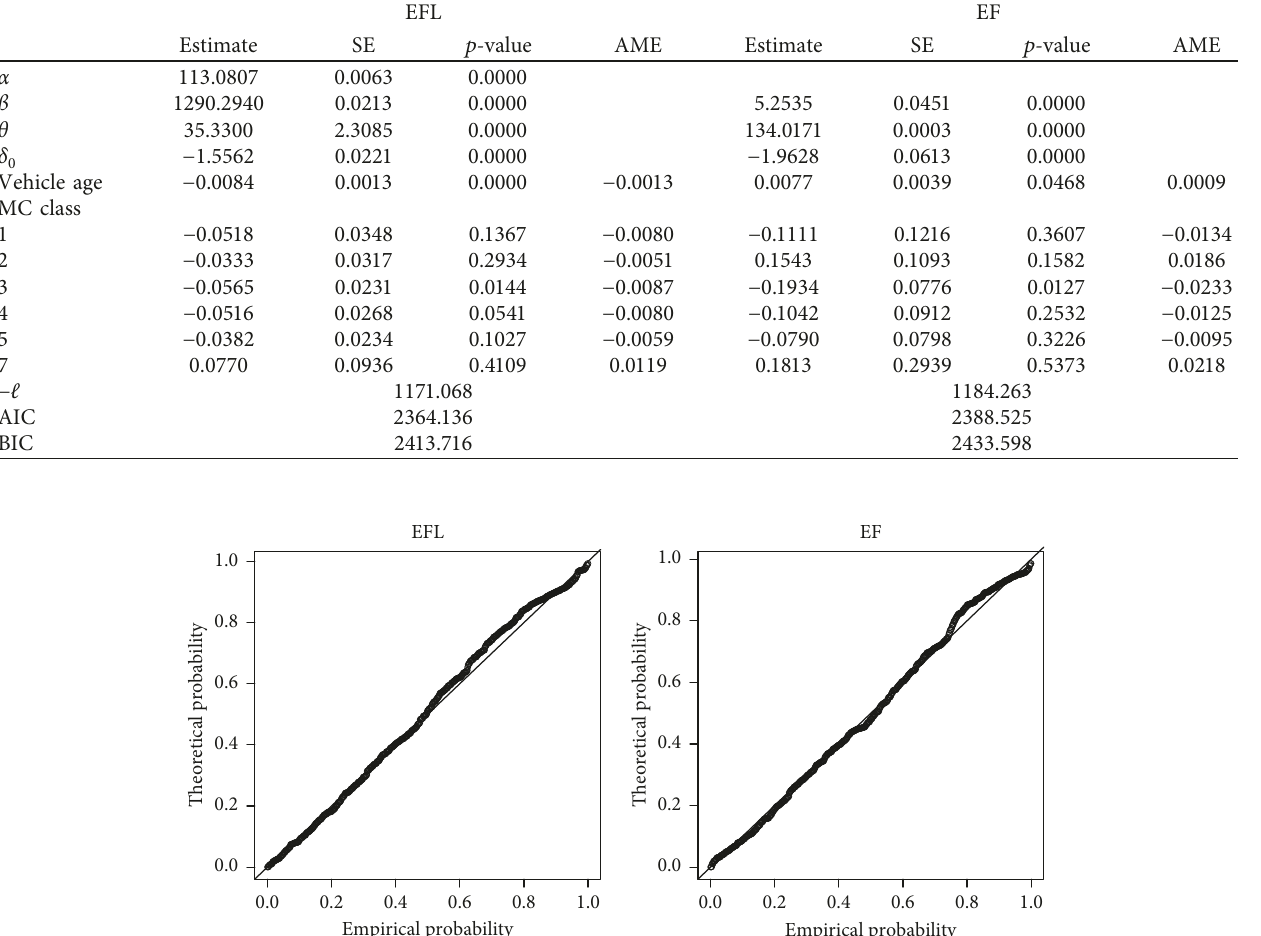
Figure 9: Cox–Snell residuals P-P